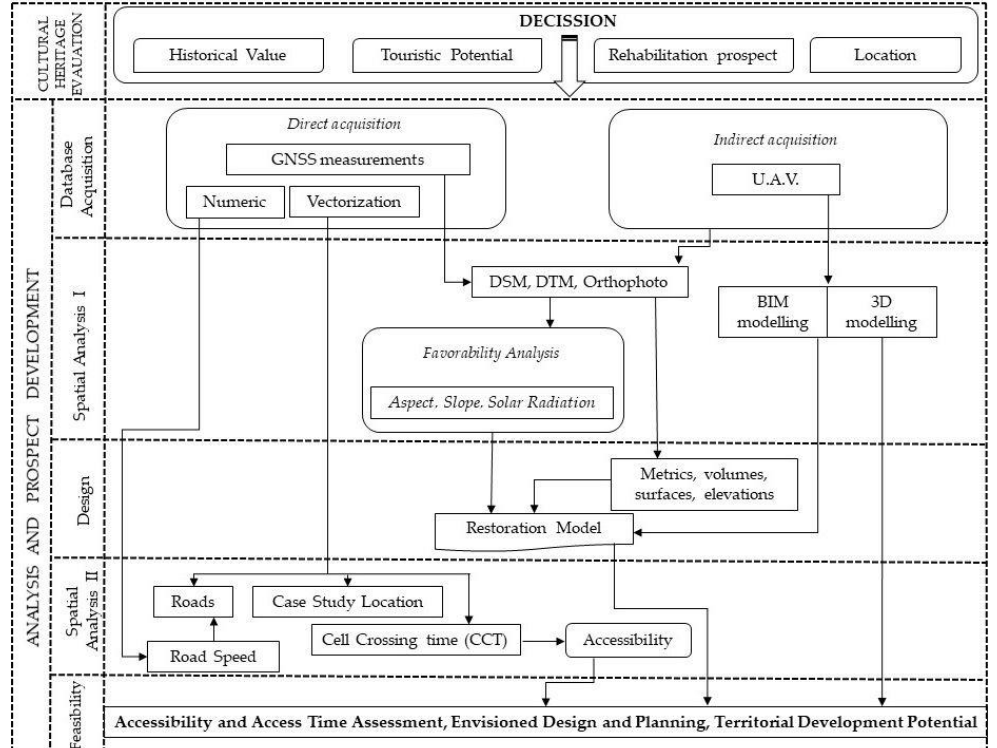
Figure 4. Methodological flowchart.